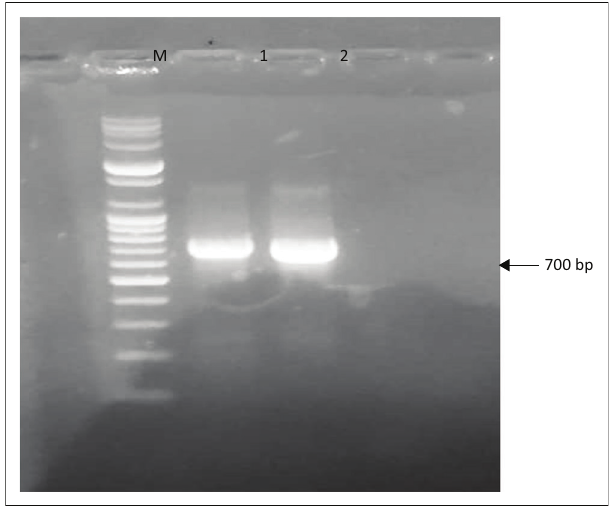
FIGURE 4: Agarose gel electrophoresis of ribulose-1,5-bisphosphate carboxylase gene of I. doka and I. tomentosa .